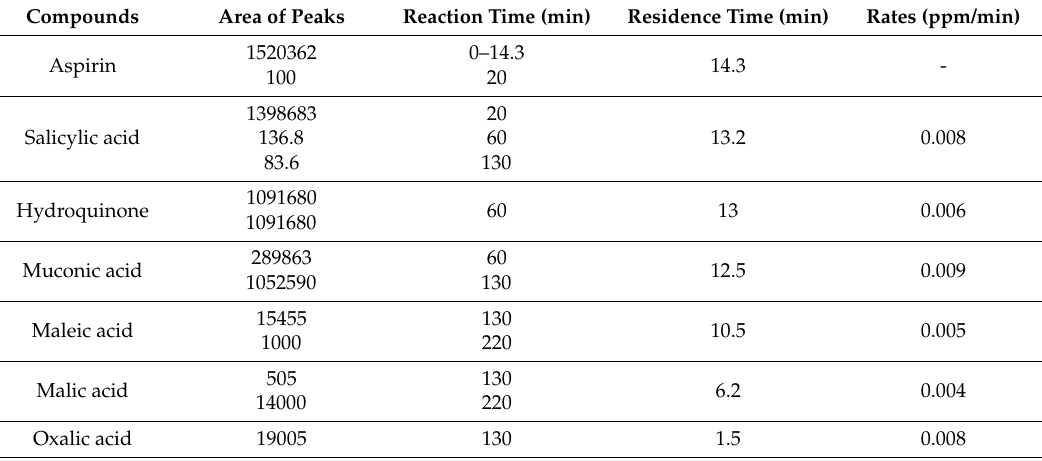
Figure 2. Mass spectra for aspirin degradation. Table 1. Identification of